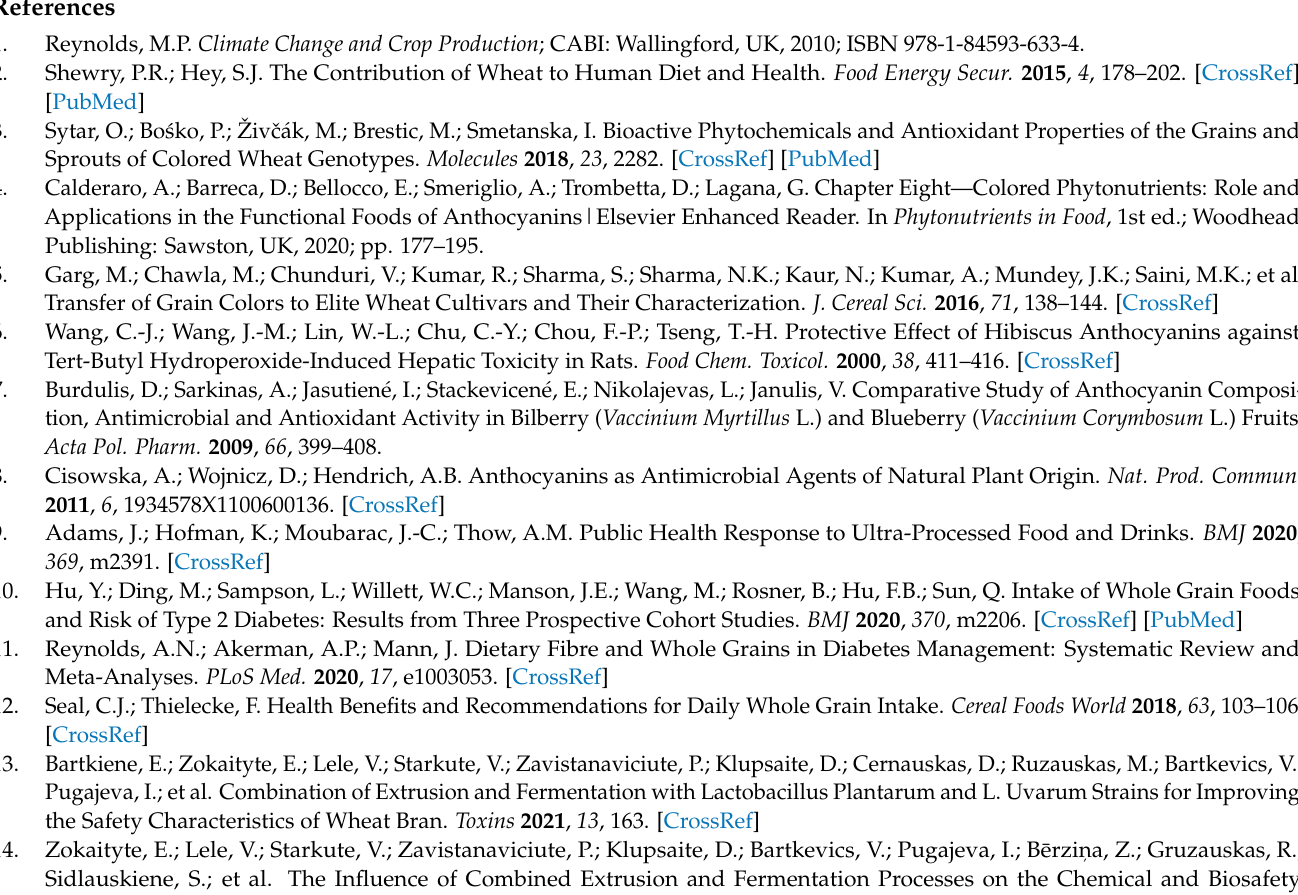
samples. Table S8. The influence of the wheat variety and type of LAB on the fatty acid content in WW samples. Supplementary File S5. Wheat sample volatile compounds: Table S9. Volatile compounds that are >5% in at least one wheat wholemeal sample. Table S10. Volatile compounds that are >1% and <5% in at least one wheat wholemeal sample. Table S11. Volatile compounds that are <1% in at least one wheat wholemeal sample. Table S12. The influence of the wheat variety and type of LAB on the acidity, chromaticity, and microbiological characteristics of the WW